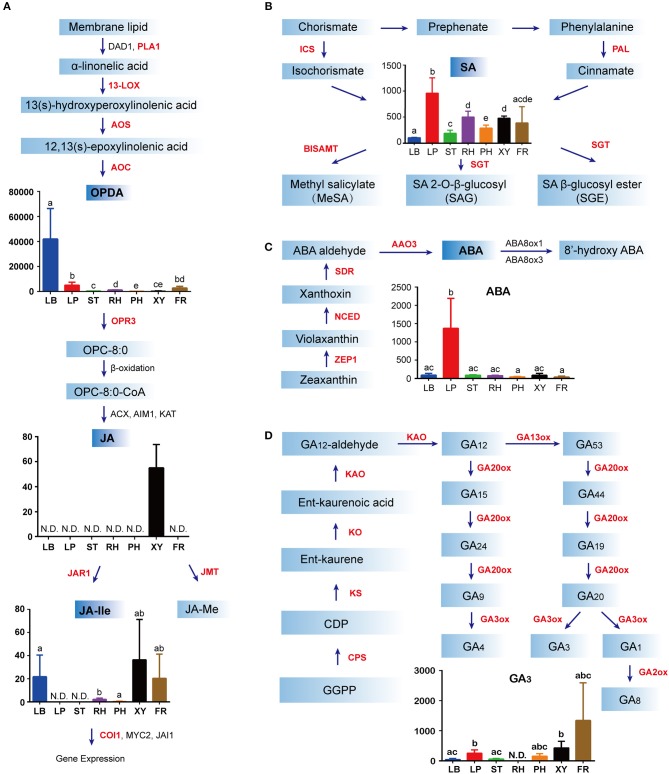
Biosynthesis and distribution of phytohormones in Panax ginseng. Jasmonates (JAs) (A), abscisic acid (ABA) (B), salicylic acid (SA) (C), and gibberellins (D) in specific spatial regions are quantified as ng·g−1 fresh weight (FW) on the y-axis of each graph. For each tissue, the number of biological replicates was n = 3 unless stated otherwise. N.D. indicates not detected. Error bars indicate the standard deviation (SD). Significant differences in metabolite concentrations among the tissues were analyzed via analysis of variance and Tukey's multiple comparison test. Different letters indicate significant differences of the means (P < 0.05). Means with the same letter or with a common letter are not significantly different from each other. Red font indicates hormone metabolism genes detected in the RNA-Seq data. The colors in (A–D) indicate different regions of ginseng: blue, leaf blade (LB); red, leaf peduncle (LP); green, stem (ST); purple, rhizome (RH); orange, phloem and periderm in the main root (PH); black, xylem in the main root (XY); brown, fibrous root (FR). Enzyme abbreviations: AAO3, abscisic aldehyde oxidase 3; ABA8ox1 abscisic acid 8- hydroxylase 1; ABA8ox3, abscisic acid 8-hydroxylase 3; ACX, acyl-coA oxidase 3; AIM1, abnormal inflorescence meristem; AOC, allene oxide cyclase; AOS, allene oxide synthase; BISAMTL, benzothiadiazole salicylic acid carboxyl methyltransferases; COI, coronatine insensitive; CPS, copalyl diphosphate synthase; DAD1, defective in anther dehiscence 1; GA2OX1, gibberellin 2 oxidase 1; GA2OX8, gibberellin 2 oxidase 8; GA20OX3, gibberellin 20 oxidase 3; GA3ox1, gibberellin 3-beta-dioxygenase; ICS, isochorismate synthase; JAI1, jasmonate insensitive 1; JAR1, jasmonate resistant 1; JMT, jasmonic acid carboxyl methyltransferase; KAO, ent-kaurenoic acid oxidase; KAT, 3-keto-acyl-coA thiolase 1; NCED, 9-cisepoxycarotenoid dioxygenase; KO, ent-kaurene oxidase; KS, ent-kaurene synthase; MYC2, myelocytomatosis proteins 2; OPDA, (9S,13S)-12-oxo-phytodienoic acid; OPR3, oxophytodienoate reductase 3; PAL, phenylalanine ammonia lyase; PLA1, preferring phospholipase A1; SGT, sterol glucosyltransferase; SDR, short-chain dehydrogenase reductase; ZEP, zeaxanthin epoxidase; 13-LOX, 13-lipoxygenase.